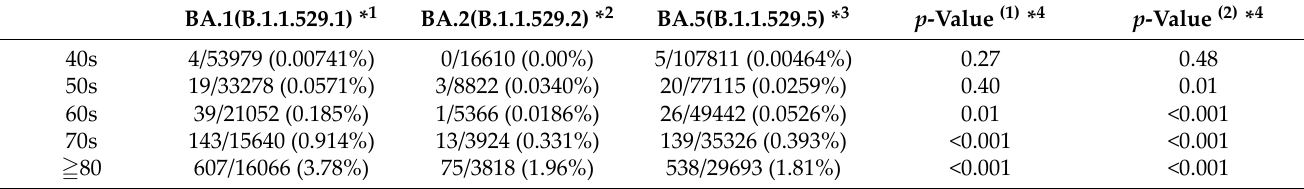
Table A3. Fatality rates of COVID‑19 cases caused by one of three sublineages of the Omicron variant in Japan, 2022 (40s, 50s, 60s, 70s and ≧ 80